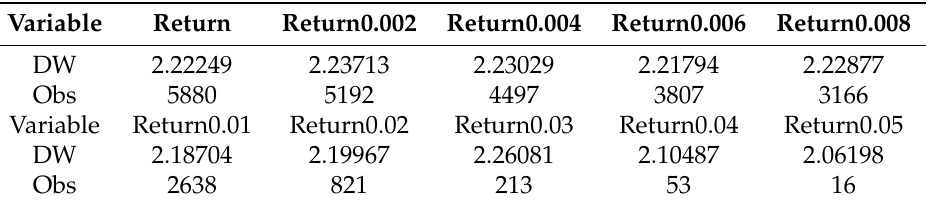
Table 4. Durbin–Watson Test on model (5).